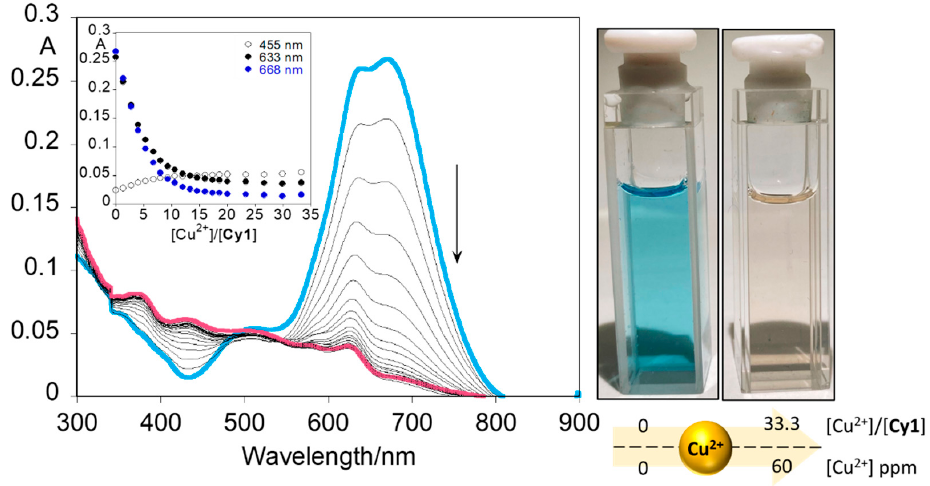
Figure 7. Absorption spectra of Cy1 doped PMMA nanoparticles (500 µM CTAB) and colourimetric aspect, in water, before and after titration, with increasing volumes of a 0.01 M Cu 2+ aqueous solution from 0 to 33.3 equivalents (0 to 60 ppm, respectively); inset depicts absorption variations at 455, 633 and 668 nm.